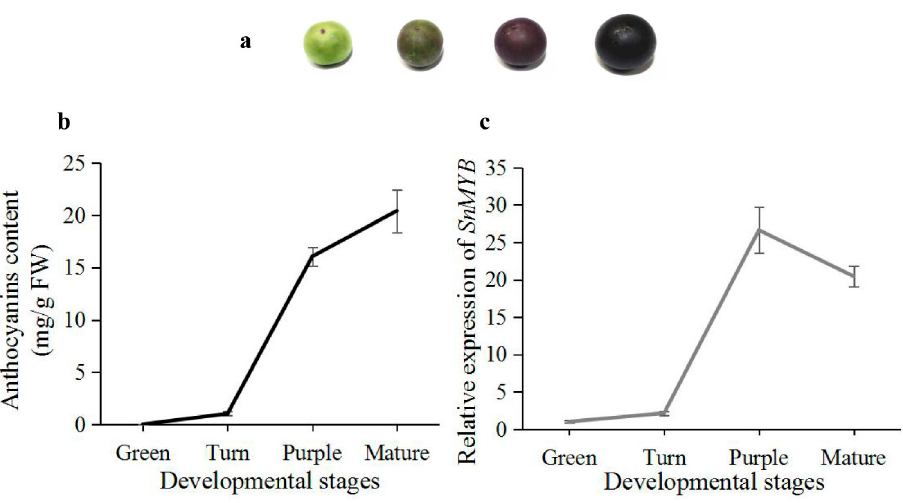
Figure 5. Correlation analysis of SnMYB expression with anthocyanin content in different developmental stages of the S. nigrum peel. ( a ) Color change with S. nigrum fruit maturation; ( b ) Determination of anthocyanin content; and ( c ) SnMYB expression levels in four developmental stages of the S. nigrum peel.